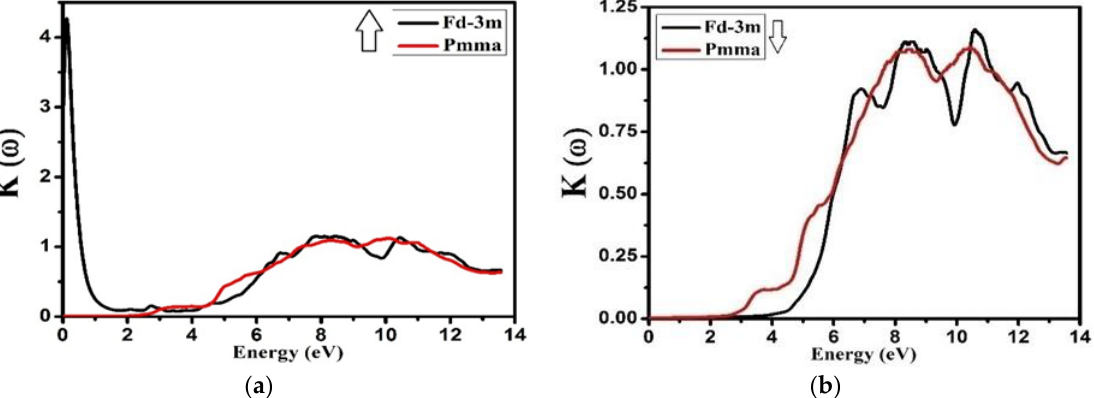
Figure 8. Calculated extinction coefficient K (ω) for Nd 2 Zr 2 O 7 ((black color for Fd-3m) and (red color for Pmma)) using GGA+U. ( a ) The spin-up direction ( ↑ ) and ( b ) spin-down ( ↓ ) direction.